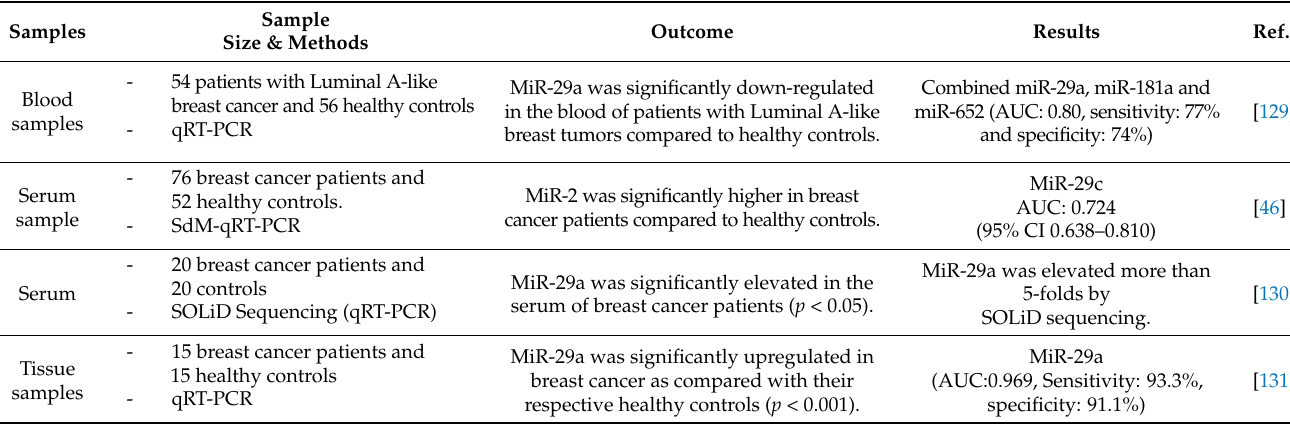
Table 4. miR-29s as biomarkers in breast